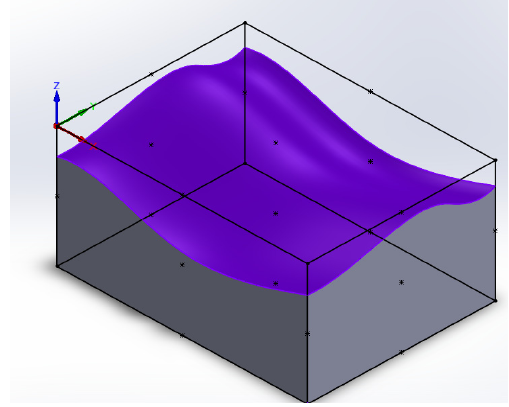
Figure 2. CAD model of the workpiece